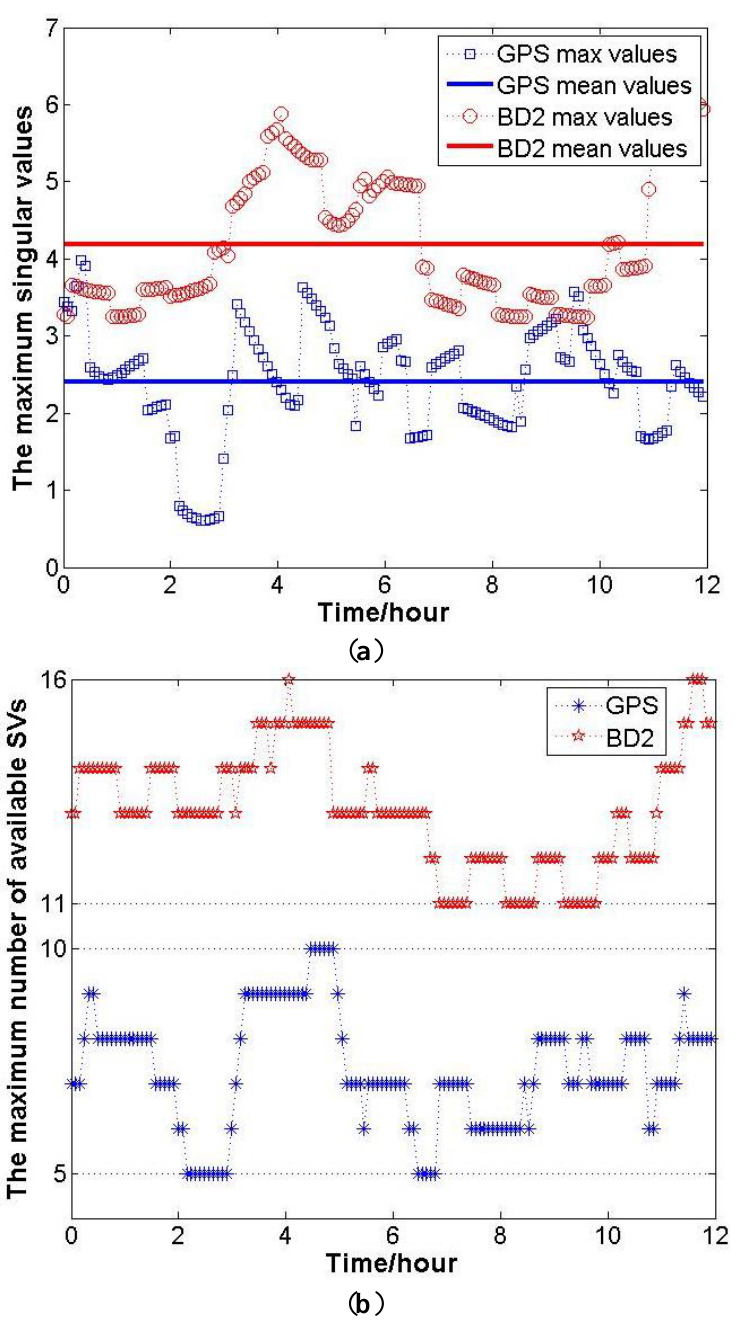
 and the mean values during 12 h in Changsha; Figure 1. ( a ) The variation of max ( b ) The variation of maximum numbers of available satellites in Changsha during 12